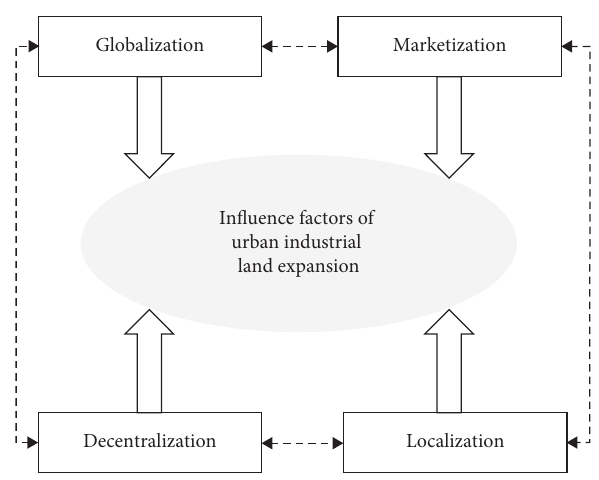
Figure 1: Analytical